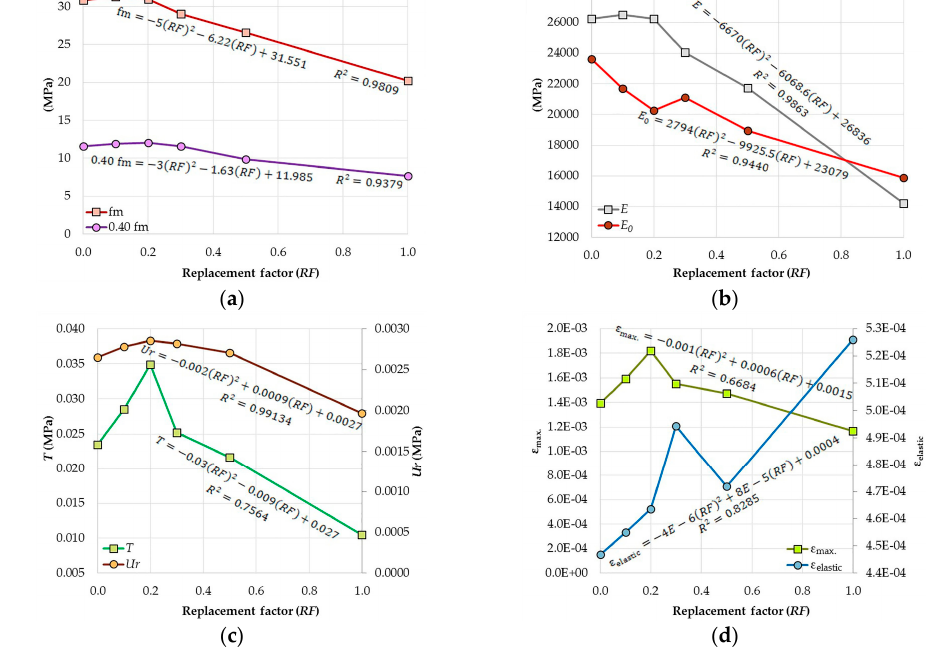
Figure 10. Graphs of the different properties of the RCM vs. RF : ( a ) RF vs. fm and 0.4 fm; and ( b ) RF vs. E and E 0 ; ( c ) RF vs. T and U r ; ( d ) RF vs. ε max. and ε elastic .